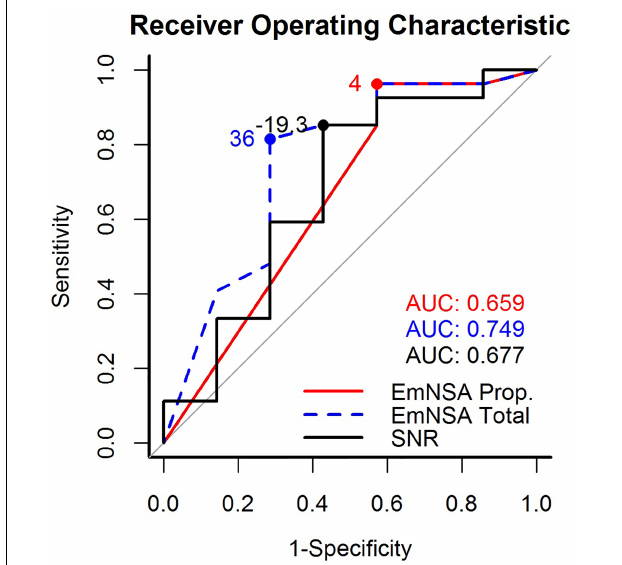
FIGURE 5 | Receiver operating characteristic (ROC) curves for the proprioception score of the EmNSA-UE, the total score of the EmNSA-UE and SNR. The area under curve (AUC) for each ROC curve as well as the optimal cut-off score to distinguish between recoverers and non-recoverers are given as text inset.